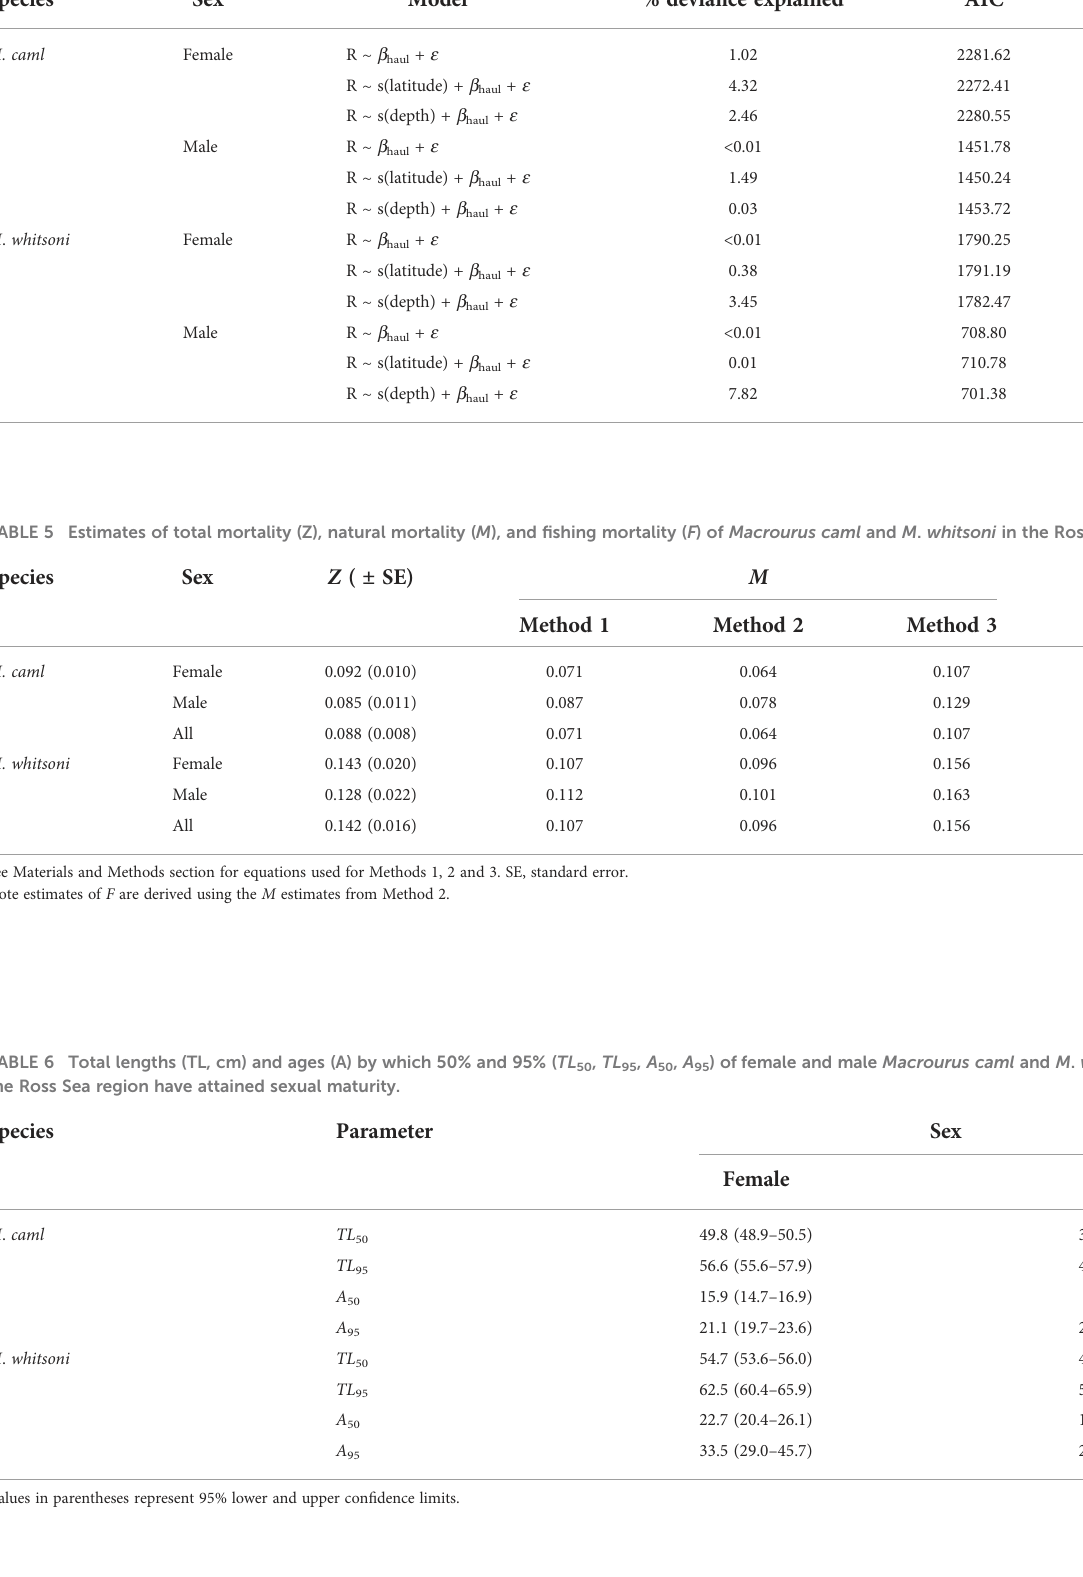
TABLE 4 Parameters and fi t of generalized additive mixed effect models exploring the effect of latitude and depth on residual length-at-age for Macrourus caml and M . whitsoni in the Ross Sea region. Species